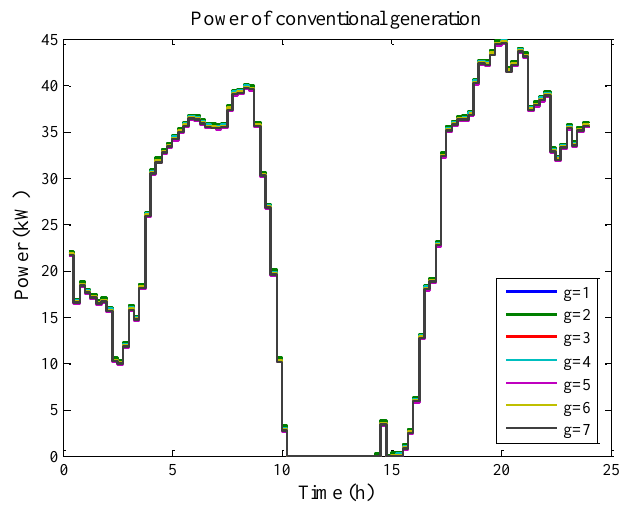
Figure 28. Conventional power time series (Case study 3).